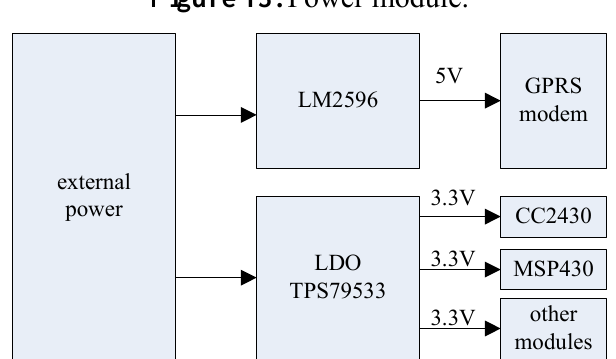
Figure 13. Power